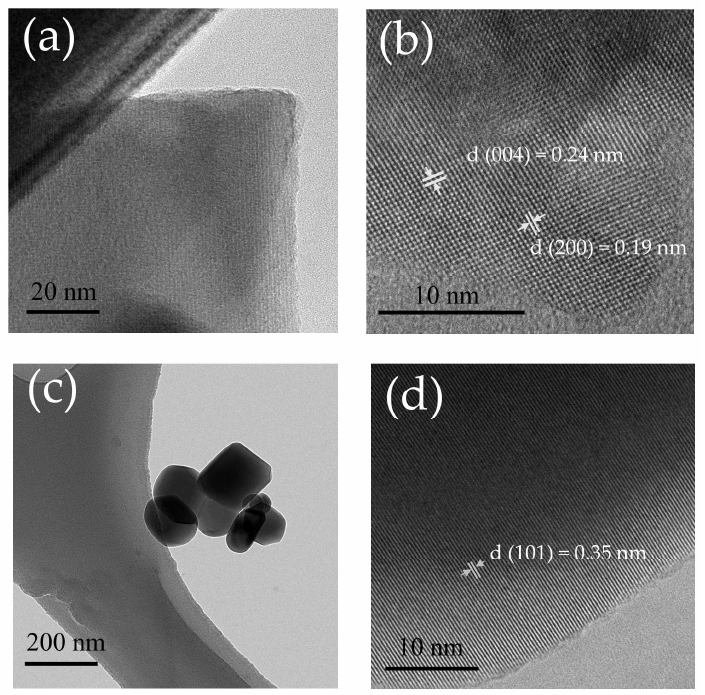
Figure 3. TEM of anatase (TiO 2 ) with exposed (001) facets ( a , b ) and anatase (TiO 2 ) with exposed (101) facets ( c , d ).